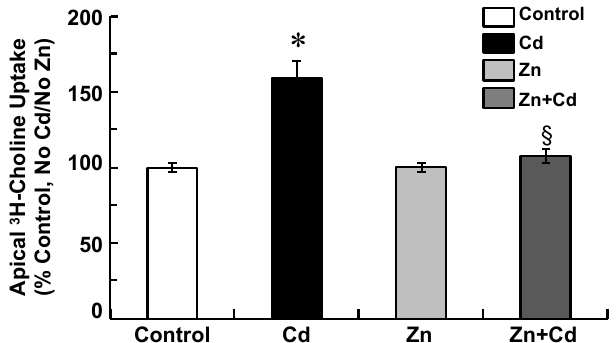
Figure 5. Thirty-minute apical uptake of 10 µM [ 3 H]choline in zinc-supplemented choroid plexus epithelial cells (CPECs) exposed for 12 h to 500 nM CdCl 2 . CPECs were first incubated for 48 h in maintenance medium without zinc, i.e., non-supplemented cells, or with 25 µM ZnCl 2 , i.e., Zn-supplemented cells. Non-supplemented cells were then pre-treated (12 h) in SFM and divided into two sets: one was incubated for 12 h in SFM with 0 CdCl 2 (Control), while the other was exposed for 12 h to 500 nM CdCl 2 in SFM (Cd). In parallel, Zn-supplemented cells were pre-treated (12 h) in SFM with 10 µM ZnCl 2 and divided into two sets: one set was exposed for 12 h in SFM with 10 µM ZnCl 2 (Zn), while the other was exposed for 12 h to 500 nM CdCl 2 in SFM with 10 µM ZnCl 2 (Zn + Cd). All treatments were at 37 °C. After experimental treatments, cells were rinsed and incubated (30 min, 37 °C) in artificial CSF (10 mM Tris-HEPES, pH 7.4) with 10 µM [ 3 H]choline chloride ± 750 µM hemicholinium-3. Uptake was measured in triplicate in three different culture preparations ( n = 3). Uptake was expressed as percentage of control; data are means ± SE; n = 3. * p < 0.05 vs. Control. § p < 0.05 vs. Cd.